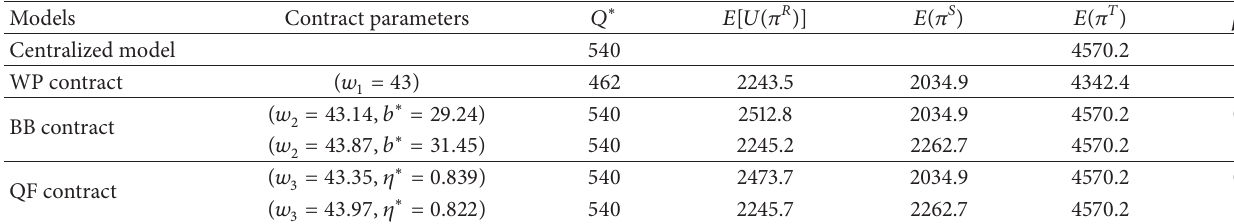
Table 2: Performance of the supply chain with different contracts.